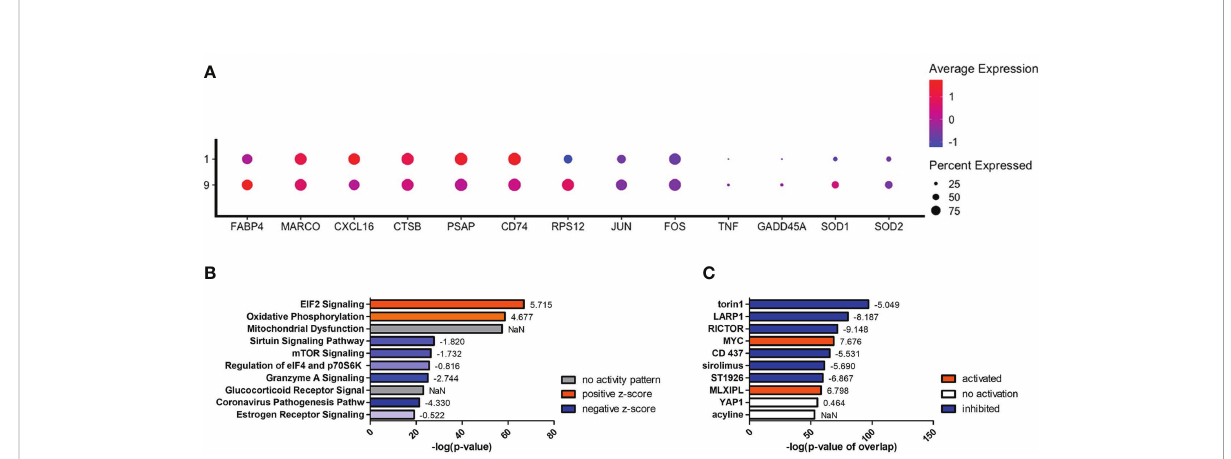
FIGURE 8 Differentially Expressed Genes in Cluster #9 Led to Changes in Cellular Stress Response and Metabolism. Processed human BAL cells were enriched for phagocytic APCs and incubated with C neoformans strain H99 for 2h and processed for scRNA-seq. Genes differentially expressed in cluster #9 when compared to cluster #1 were analyzed by IPA. (A) Differential expression of select genes in clusters #9 and #1. Top 10 signi fi cantly regulated canonical pathways (B) and predicted upstream regulators (C) as ordered by p -value or p -value of overlap. To the right of each bar is the statistical z-score for each pathway or upstream regulator with positive and negative being increased and decreased, respectively (NaN = not a number, no activity pattern). Data shown are combined cells from three individual experiments (n=3).